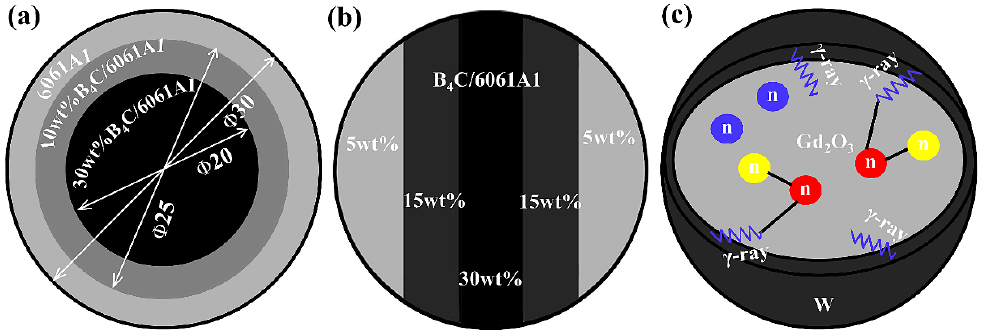
Figure 13. Schematic diagram of ( a ) (B 4 C + 6061Al)/6061Al concentric ring structure [71], ( b ) B 4 C/6061Al laminar composites [72] and ( c ) Gd 2 O 3 @W/A1 core–shell structure [73].